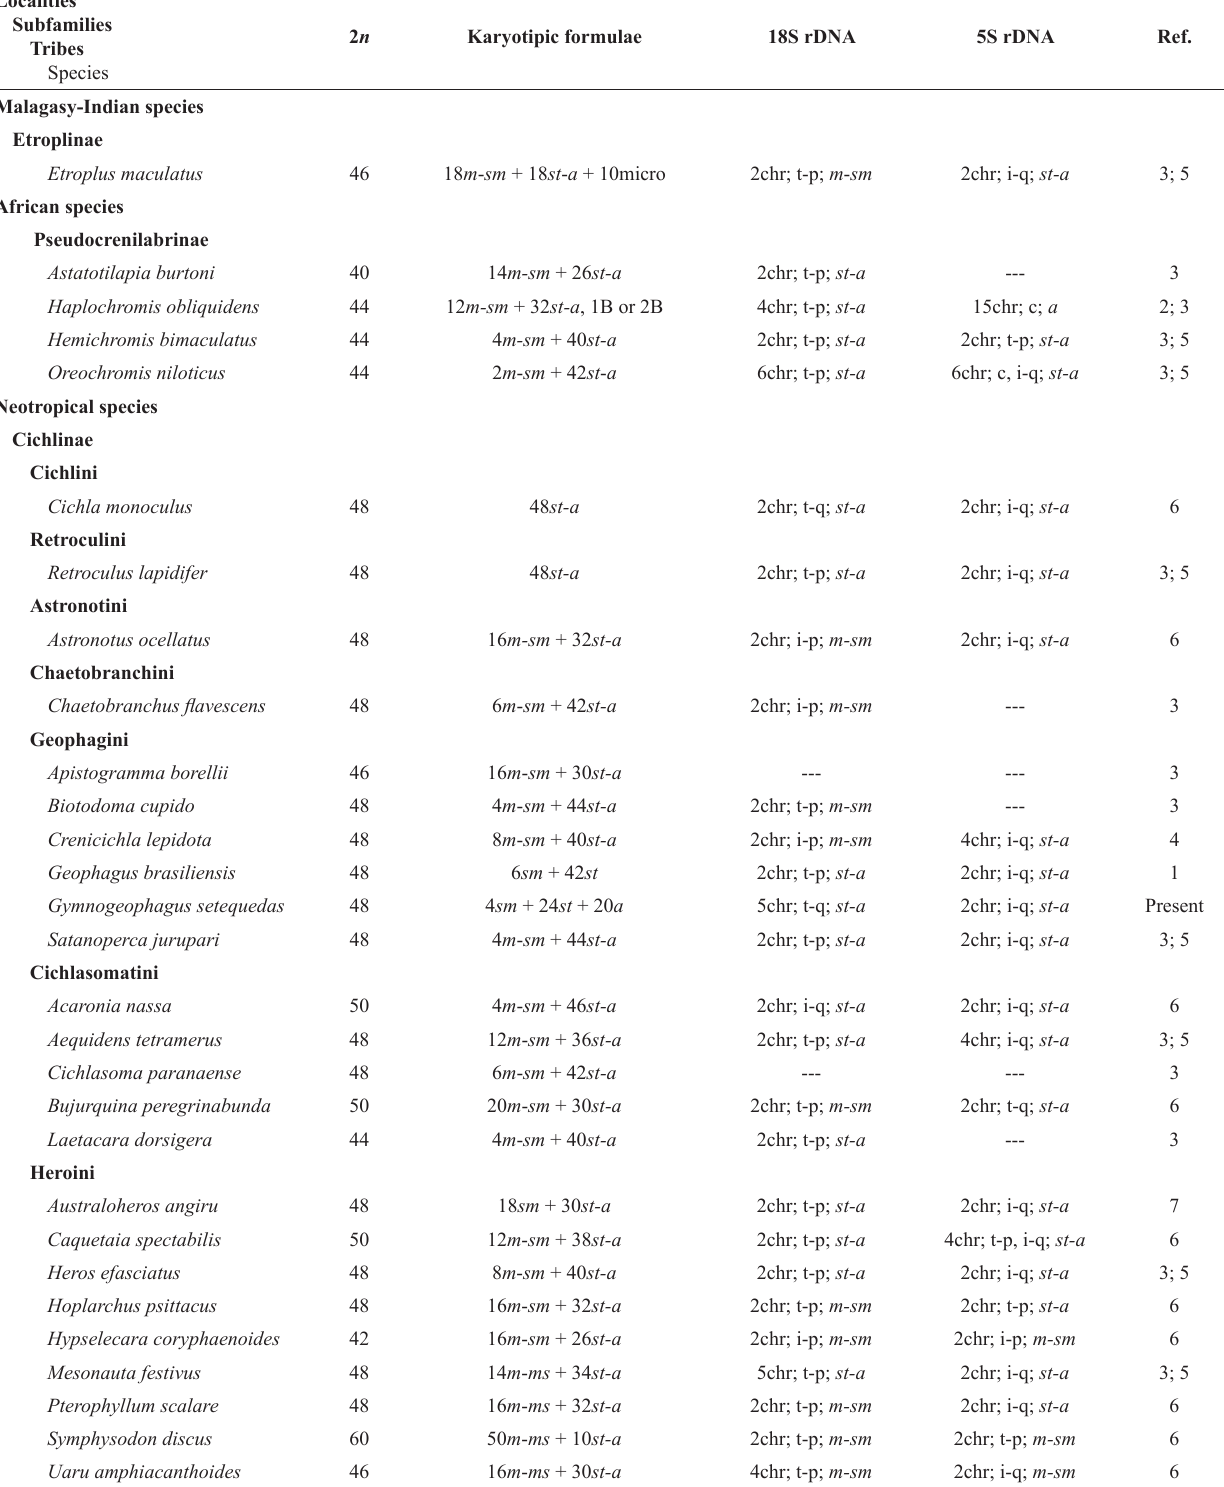
Tab. 1. Compilation of cytogenetic data including karyotype formulae, 18S and 5S rDNA for Malagasy, Indian, African and Neotropical cichlid species. 2 n = diploid number; m = metacentric; sm = submetacentric; st = subtelocentric; a = acrocentric; p = short arm; q = long arm; t = terminal position; i = interstitial position; c = centromeric position; chr = chromosomes. References: (1) Nakajima et al. (2012); (2) Paiz et al. (2014); (3) Perazzo et al. (2011); (4) Poletto et al. (2010 a ); (5)